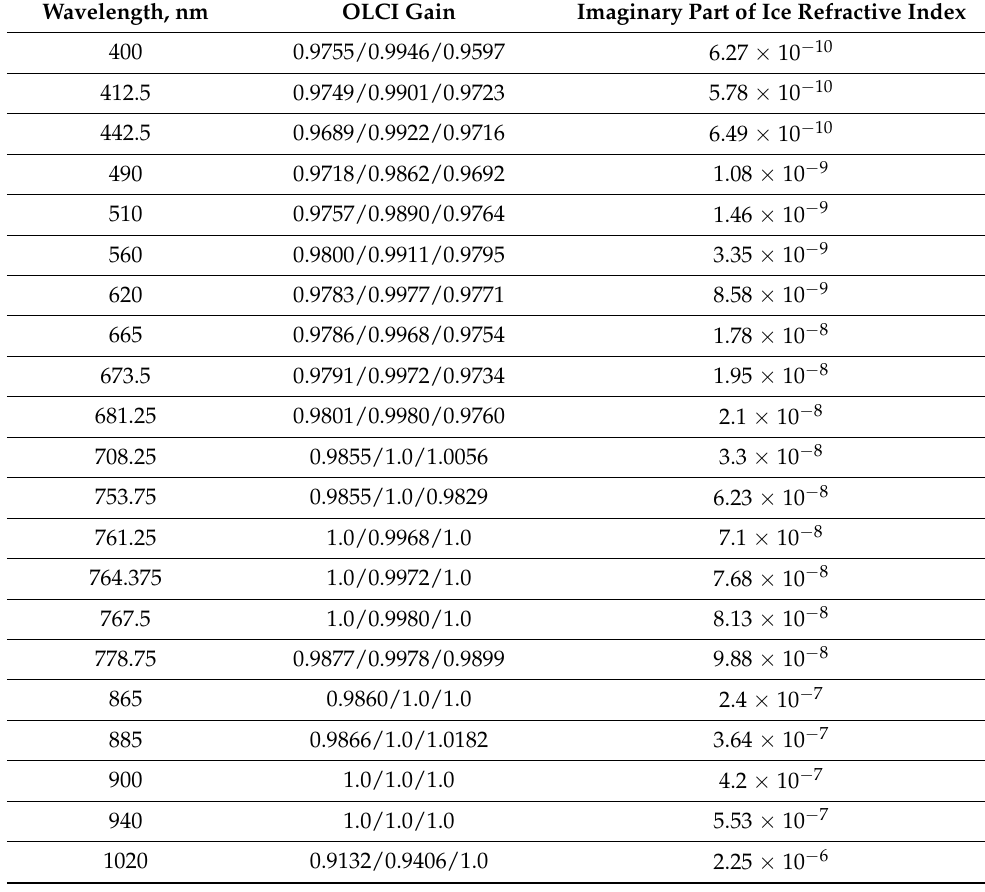
Table A1. The spectral OLCI gains and imaginary part of ice refractive index. The first (second) number in the third column corresponds to the OLCI S-3A(B) gain at a given channel [12]. The third number is the result of vicarious calibration of the OLCI (https://forum.earthdata.nasa.gov/ viewtopic.php?t=1273 (accessed on 1 December 2022)).